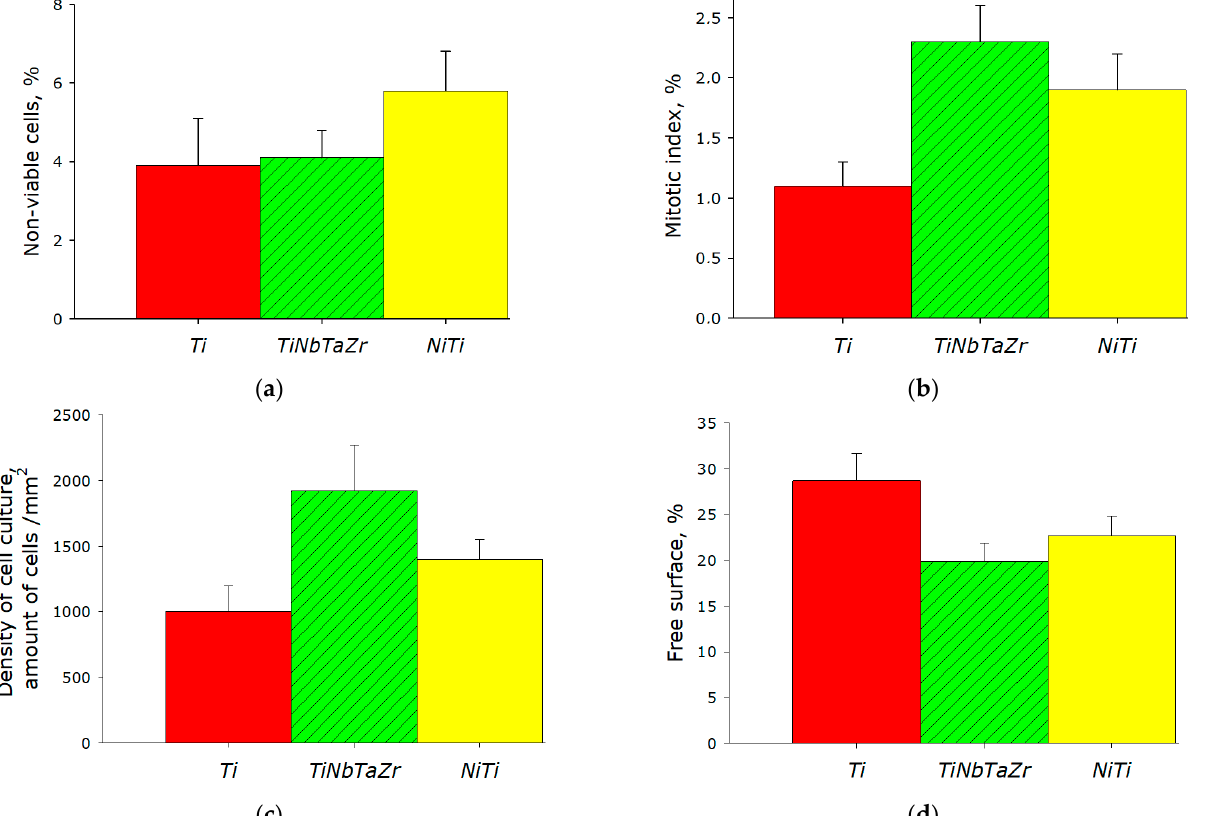
Figure 5. Impact of the Ti-20Nb-10Ta-5Zr on human cell line proliferation and viability: ( a ) effect of Ti-20Nb-10Ta-5Zr alloy on cell viability; ( b ) impact of the Ti-20Nb-10Ta-5Zr alloy on the proliferation rate (MI); ( c ) impact of Ti-20Nb-10Ta-5Zr on cell culture density; ( d ) impact of the Ti-20Nb-10Ta-5Zr on cell culture confluency.